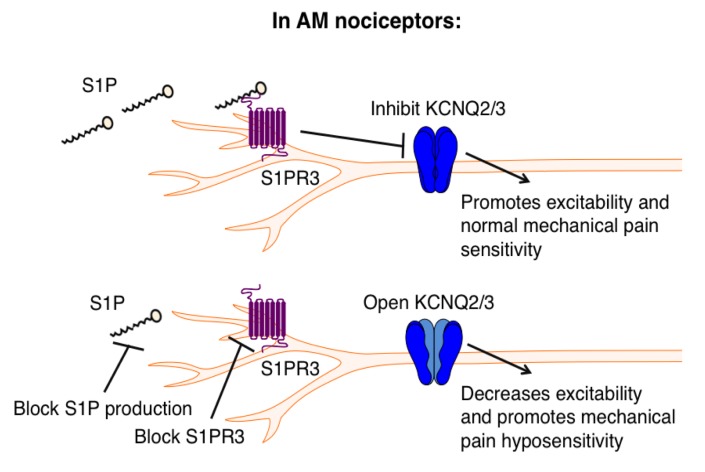
Proposed model illustrating a key role for S1PR3 in regulating mechanical pain in AM nociceptors.(Top) S1P promotes activation of S1PR3, which leads to inhibition of KCNQ2/3 currents and promotes normal mechanical pain sensitivity. (Bottom) Diminished S1P or S1PR3 antagonism alleviates inhibition of KCNQ2/3, leading to mechanical pain hyposensitivity.